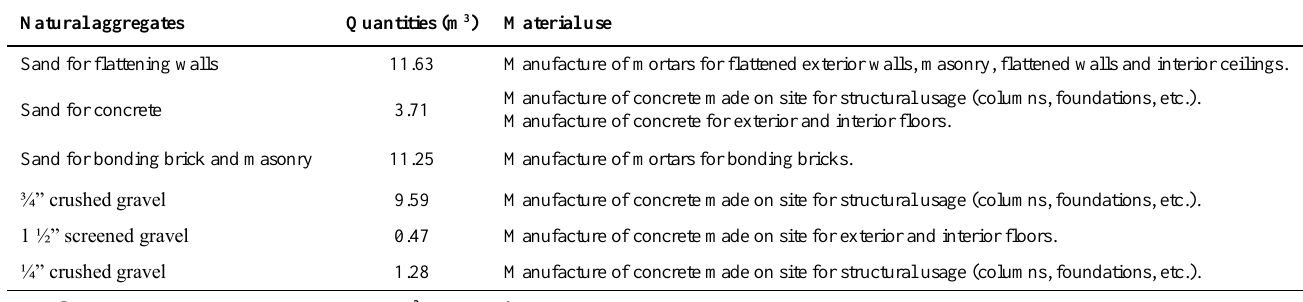
Table 2. CO 2 emissions from transfers of construction materials.